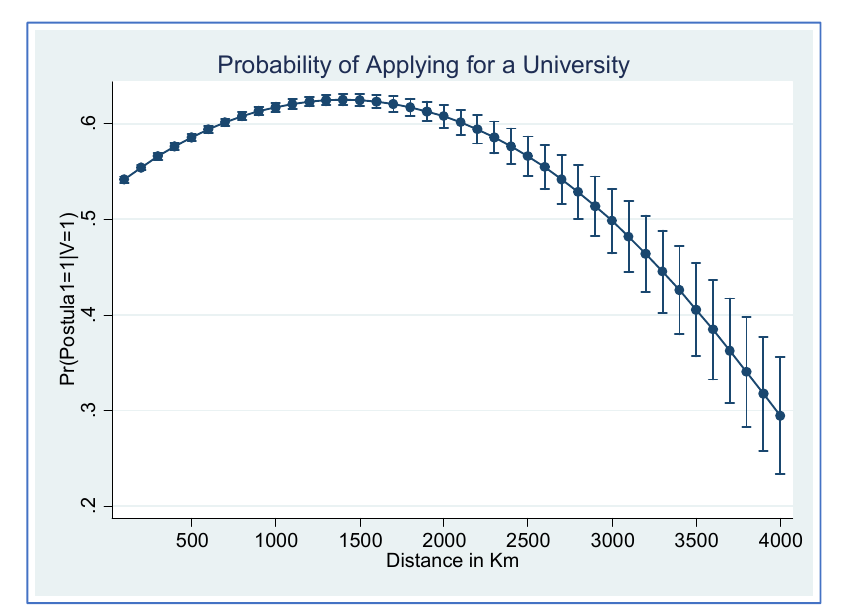
Figure 4. Effect of distance from students’ home to Santiago city on the probability of applying to university.